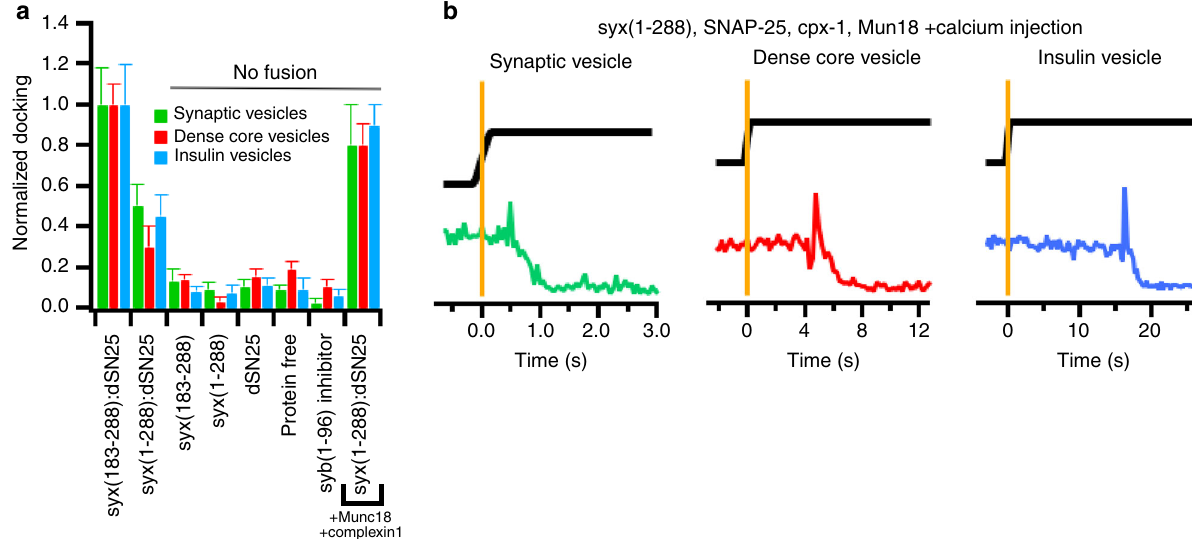
Fig. 3 Secretory vesicle docking and calcium-triggered fusion. a Docking of synaptic vesicles (green), dense-core vesicles (red), and insulin vesicles (blue depends on the presence of both target SNARE proteins syntaxin-1a and SNAP-25 in the planar-supported membrane in the absence of calcium (100 µ M EDTA)). Syntaxin-1a (183 – 288) denotes a construct containing the transmembrane domain and the SNARE motif, whereas syntaxin-1a(1-288) is the full- length protein that also contains the regulatory H abc domain. Secretory vesicle docking to planar-supported lipid bilayers containing different combinations of syntaxin-1a1-288, dSNAP-25, complexin-1, and Munc18. A summary of the statistics is shown in Supplementary Table 1. b Single-vesicle fusion events triggered by calcium from a docked state in the presence of syntaxin-1a1-288, dSNAP-25, complexin-1, Munc18, and the C1C2MUN domain of Munc13. Single events for synaptic vesicles, dense-core vesicles, and insulin vesicles are shown. Soluble Alexa647 was included in the buffer containing 100 μ M calcium to measure calcium arrival (black trace) to determine delay times of fusion. Orange line is the precise time determined for calcium arrival. The traces represent the release of respective fl uorescent content markers of acridine orange for synaptic vesicles (green), NPY-mRuby for dense-core vesicles (red), and C-peptide-GFP (blue) for insulin vesicles. Graphs with expanded times scales around the arrival time of the calcium buffer are shown in Supplementary Fig. 4 and more representative traces are shown in Supplementary Fig. 3. Error bars represent standard errors of the